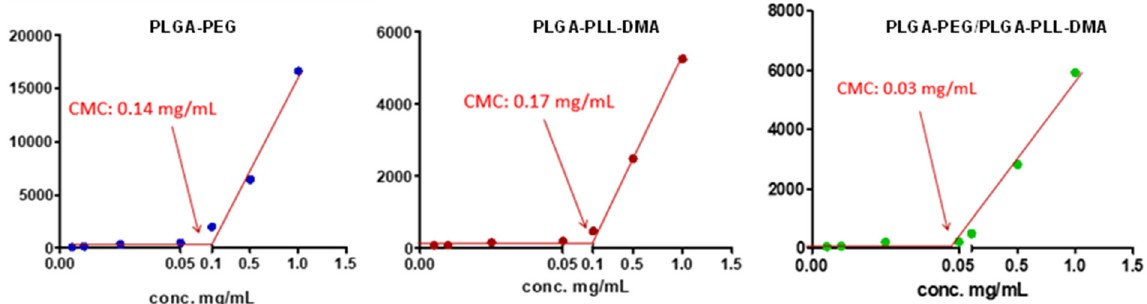
Figure 3. Scattered light intensity graph (in kilo counts per second—Kcps) obtained for the various concentrations of PLGA-PEG, PLGA-PLL-DMA, and the mixture 1:1 ( w / w ) of PLGA-PEG/PLGA- PLL-DMA prepared in deionized water. The intersection of the two lines corresponds to the critical micellar concentration.